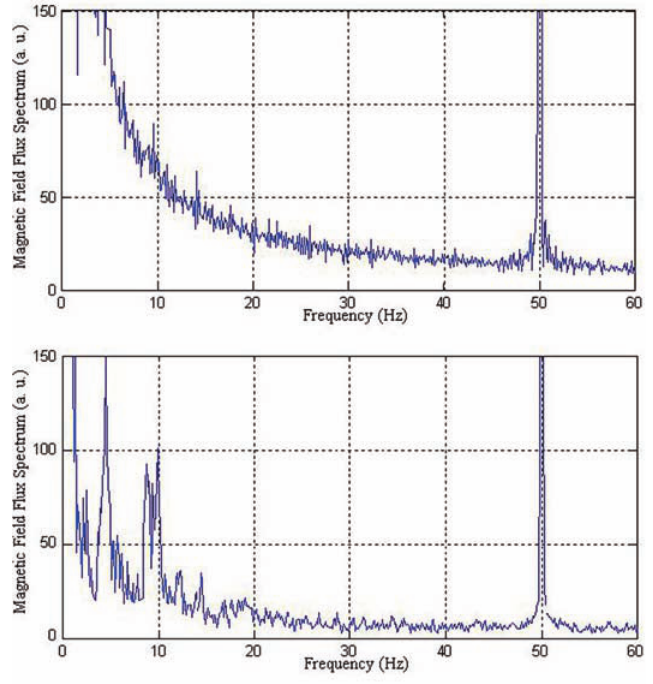
Figure 2 (left). Examples of the magnetic field flux spectra as functions of the frequency, as recorded by magnetometer n˚ 16 of the Villa Russo SQUIDS. Top: data recorded on February 4, 2010, at 12:33. Bottom: data recorded on February 4, 2010, at 10:03. The spectra refer to measurements in the "empty" situation (no-one inside the MSR), showing the ideal "empty" condition where the spectrum is characterized by an absence of peaks, except for the peak at 50Hz that is associated with the electrical power supply (top), and the anomalous peaks observed between 1 Hz and 20 Hz